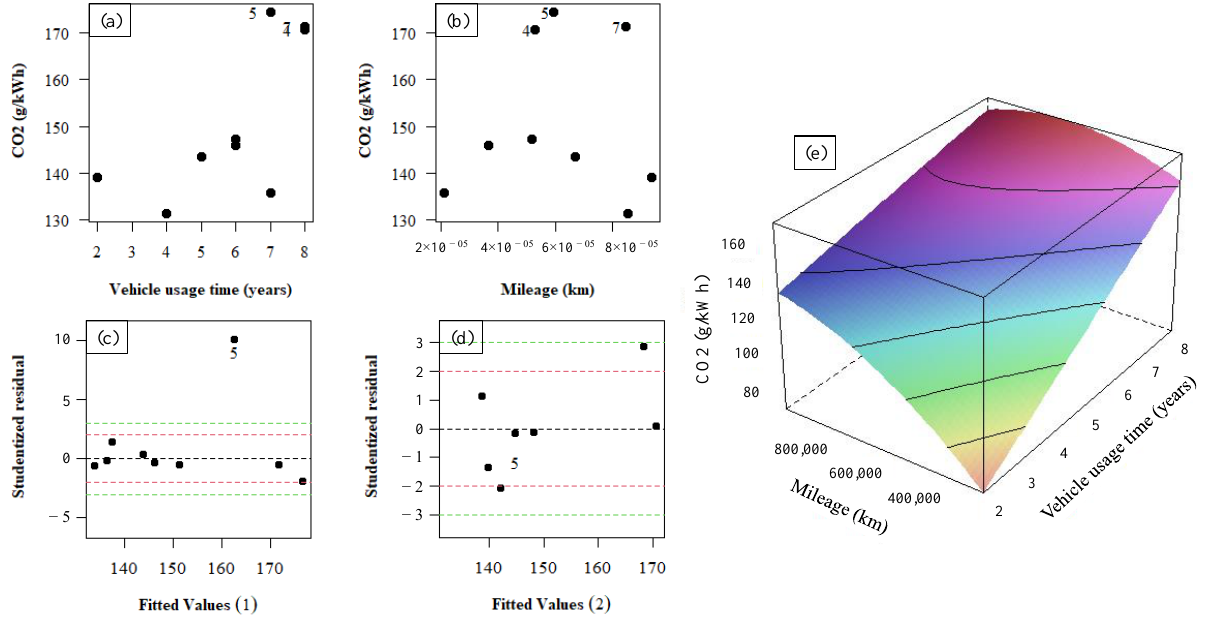
Figure 4. CO 2 fugitive emission behavior—adjustments of mileage-time relationships using a degree- 2 polynomial. ( a ) First individual fit using equation 6 with mileage as the explanatory variable. Samples 4, 5, and 7 show high emissions rates; ( b ) Second individual fit using equation 6 with time of use as the explanatory variable. Similarly, samples 4, 5, and 7 show high emission rates; ( c ) A third fit applying all terms of the polynomial equation of degree 2 indicates an atypical value for sample 5, requiring a new fit; ( d ) The fourth and final adjustment after the removal of sample 5 brought improvements to the model; ( e ) Response surface shows an increasing trend for both explanatory variables (mileage and time of use).